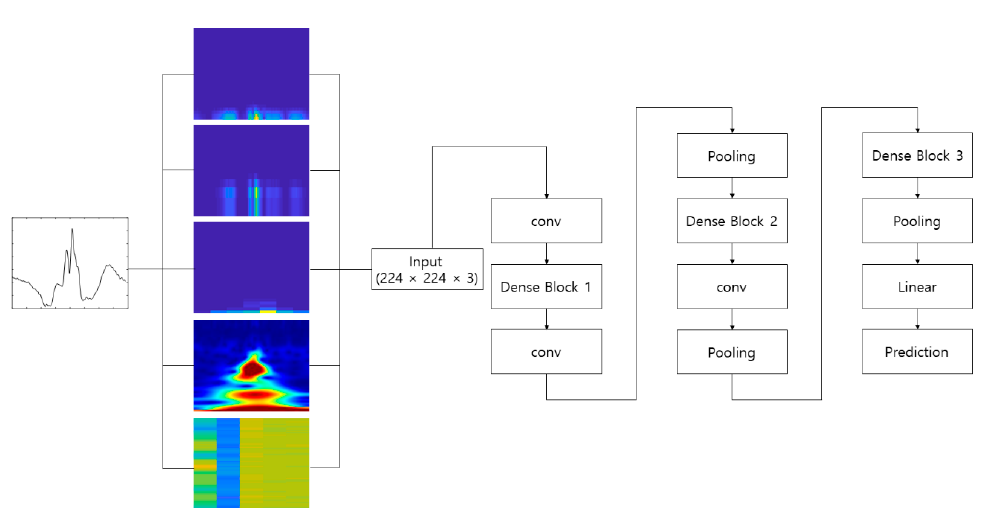
Figure 3. Structure of DenseNet with the time-frequency representations as inputs.